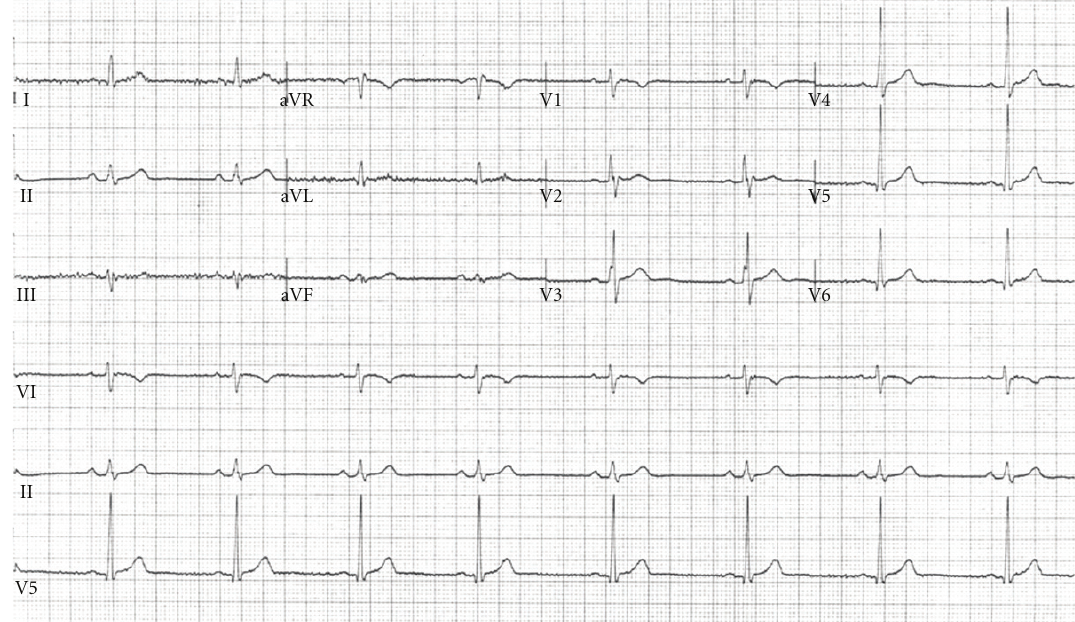
Figure 2: The patient’s ECG on hospital day 2 after he had been treated with intravenous antibiotics and had defervesced. The ECG demonstrates minor ST changes but resolution of the findings seen up on